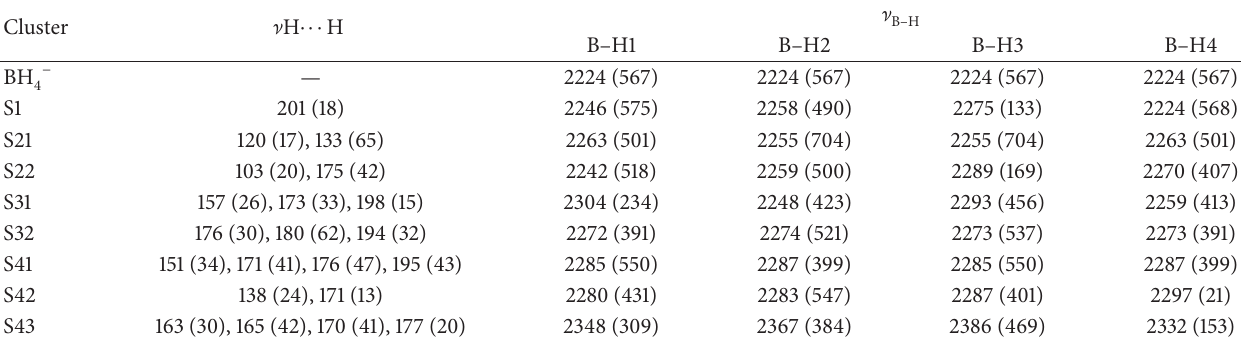
Table 5: Unscaled vibration frequencies (cm − 1 ) with corresponding intensities (values given in parenthesis, kmmol − 1 ) of HB clusters calculated at B3LYP/6-311++G(d,p)